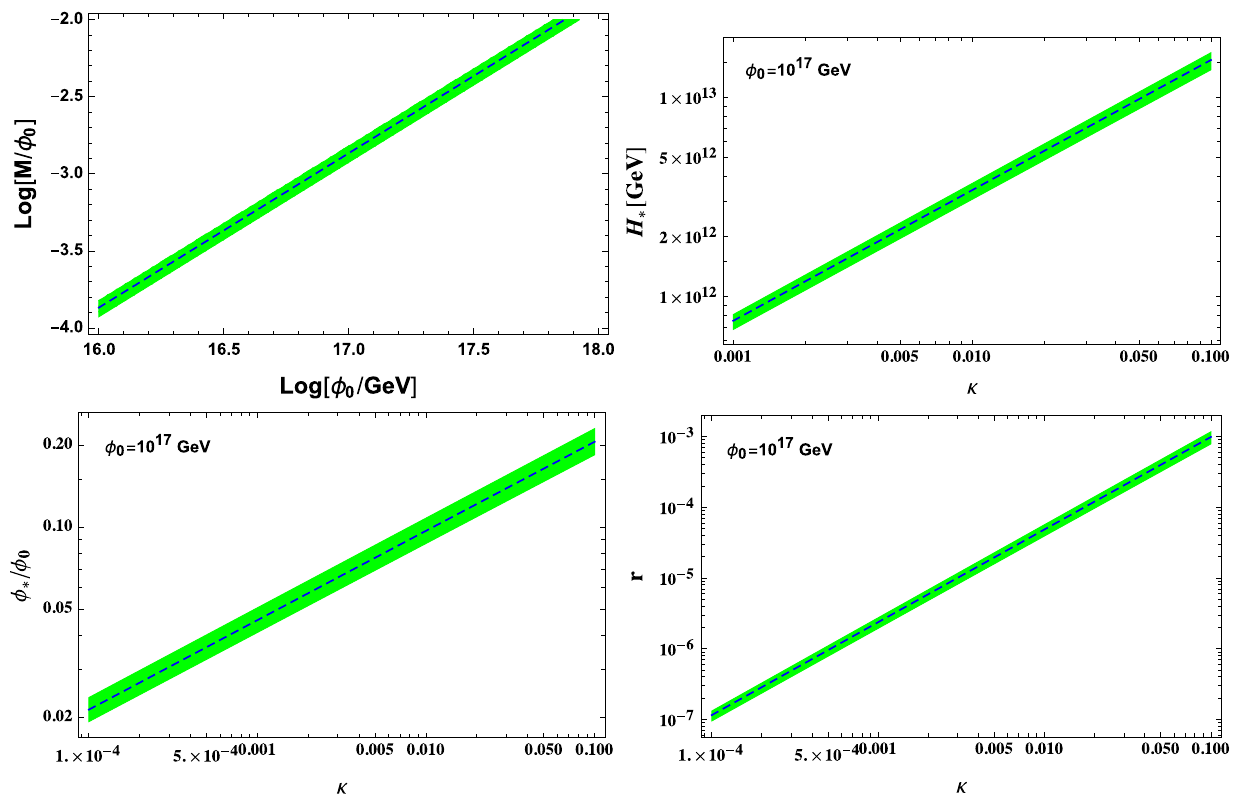
panel, the dashed line corresponds to the case of n s = 0 . 9659, and the green band represents the 2- σ allowed region of n